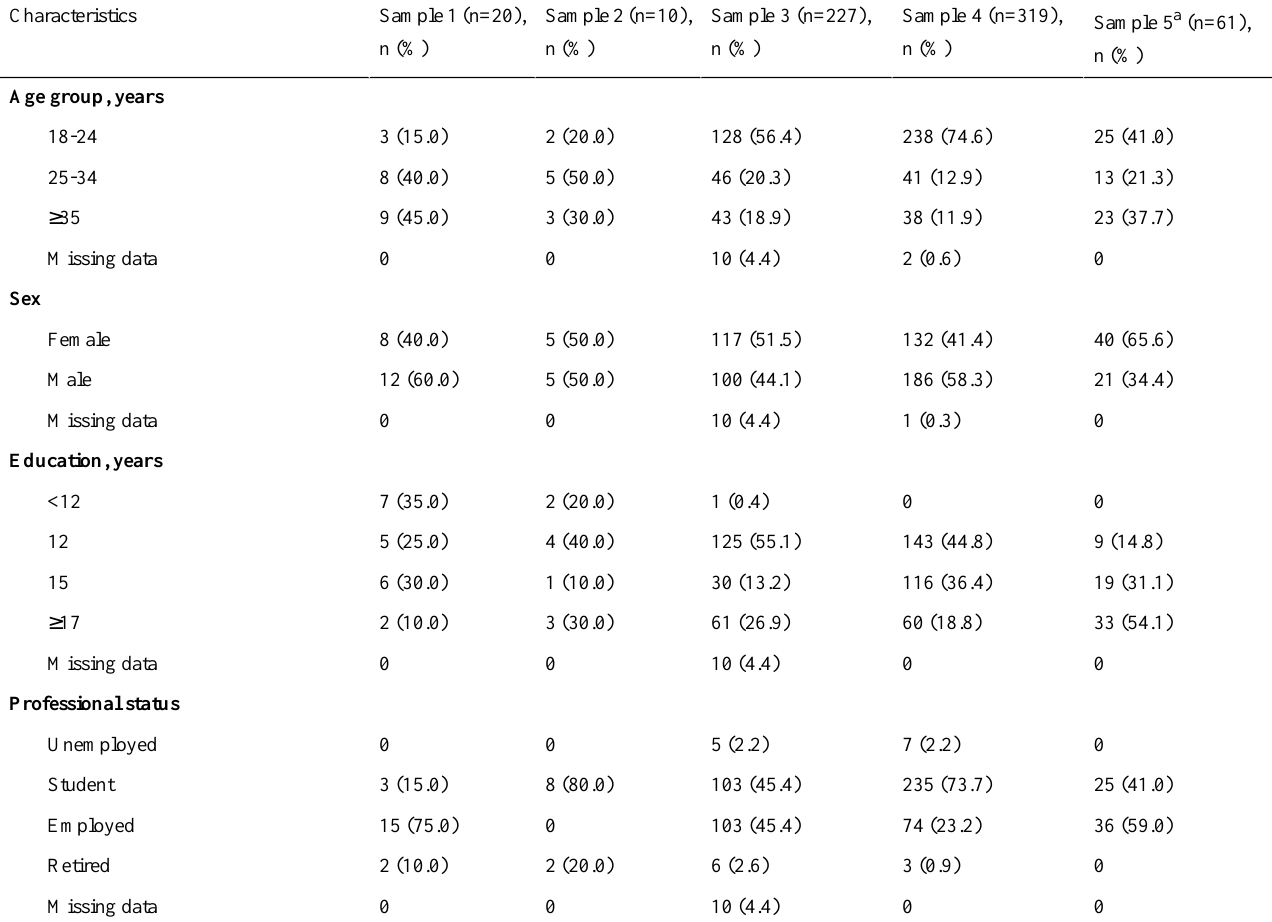
Table 1. Sociodemographic characteristics in each sample